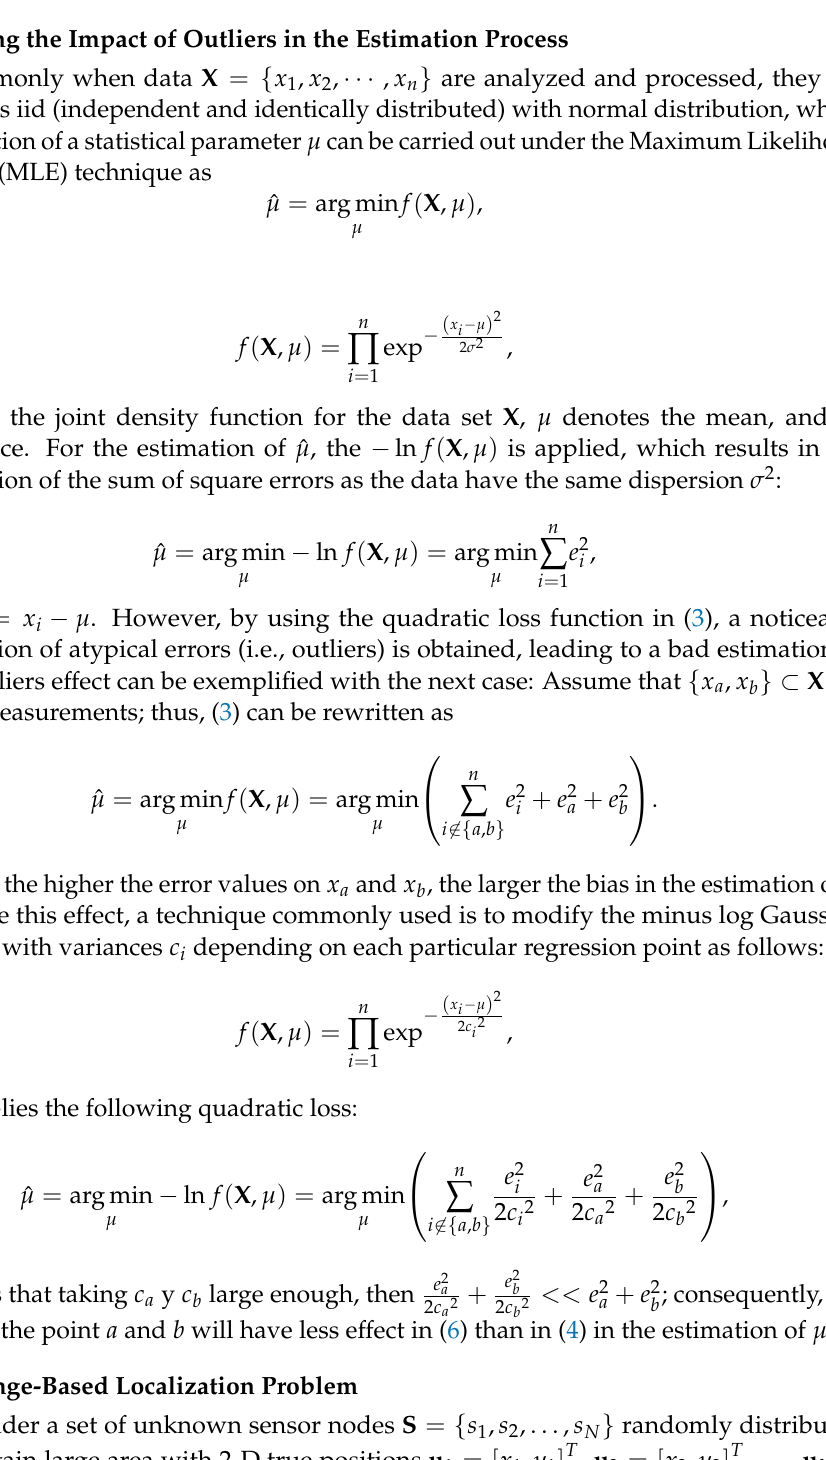
algorithm. Section 5 determines the computational complexity of the